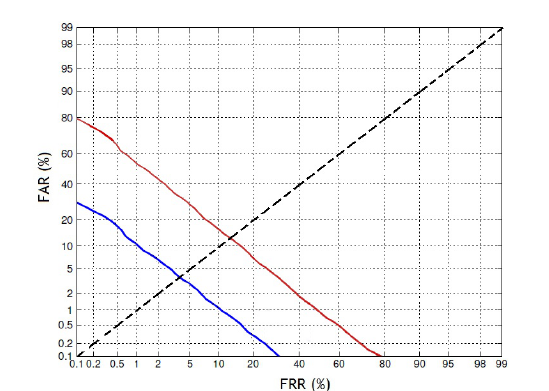
Figure 7. Score distributions of zero-effort imposters, genuine, and spoof attackers with the spoof false acceptance rate; the the x-axis represents the value of decision threshold τ , and the y-axis represents the number of trials.